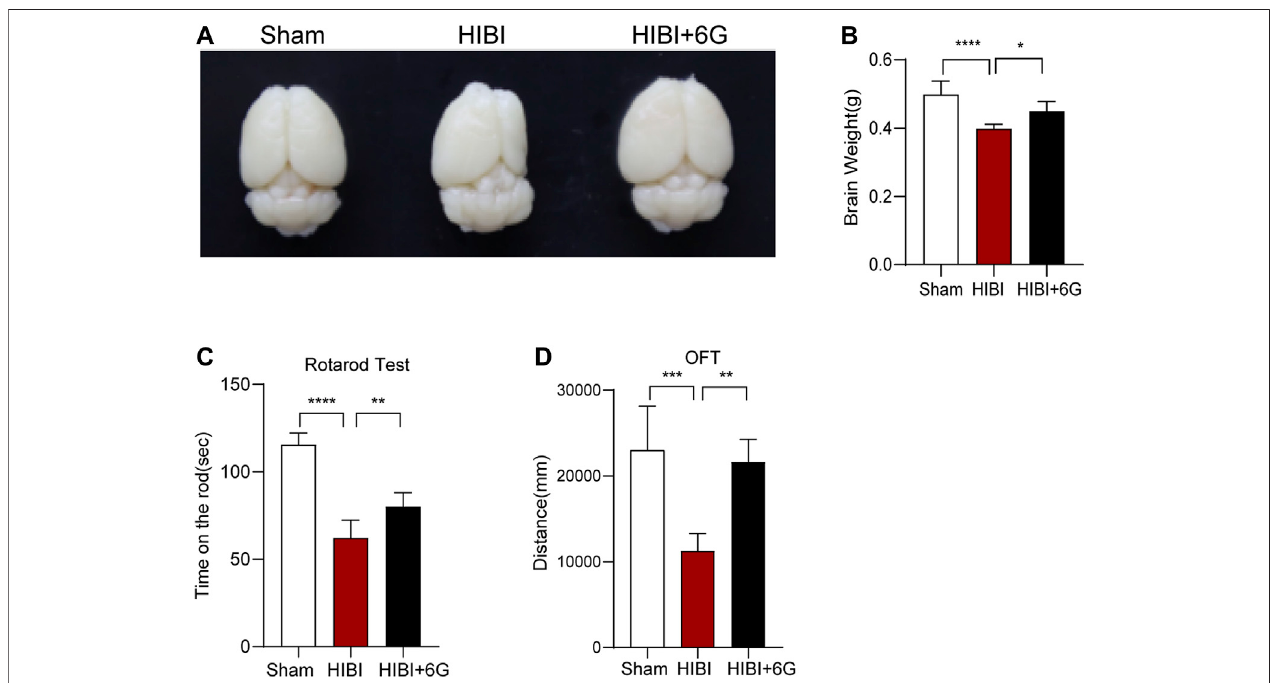
FIGURE 4 | 6-Gingerol improves HIBI-induced brain atrophy and long-term neurological de fi cits. (A) Representative images of the anatomical structure of the brainsofeach groupat4-weekpost-HIBI. (B) Brainweight ofeach group. (C) Rotarodtestforthemotorcoordination evaluation ofeach groupat4-weekpost-HIBI. n (cid:1) 6 per group. (D) Open fi eld test for total distance results of each group. n (cid:1) 5 per group. Data represent the mean ± SEM. * p < 0.05, ** p < 0.01, *** p < 0.001, **** p <